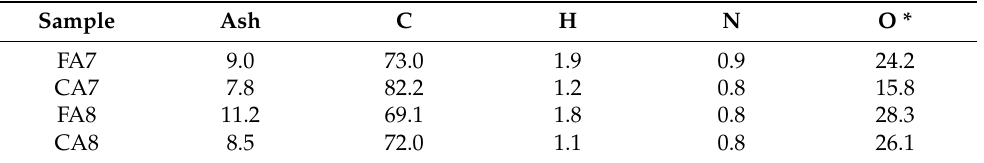
Table 1. Elemental composition of the adsorbents obtained [wt.%].